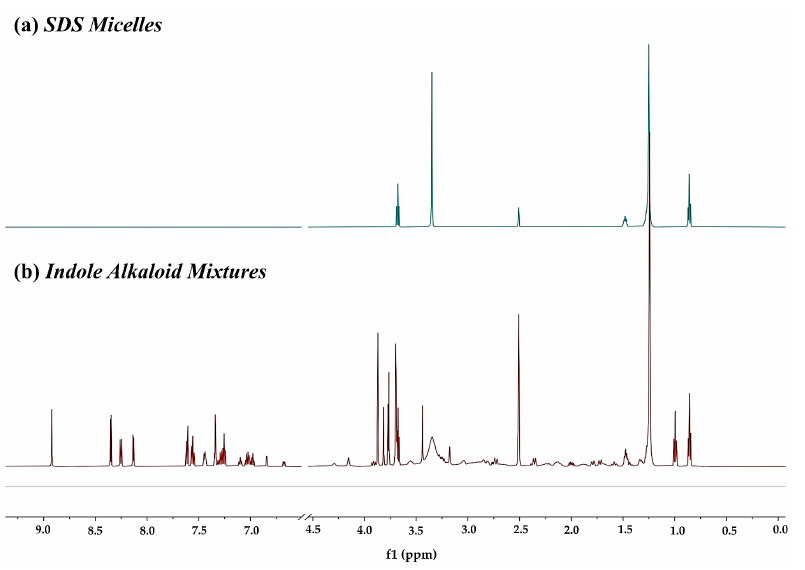
Figure 3. 1 H-NMR spectra at 600 MHz of ( a ) sodium dodecyl sulfate (SDS) and ( b ) indole alkaloid mixtures with SDS.